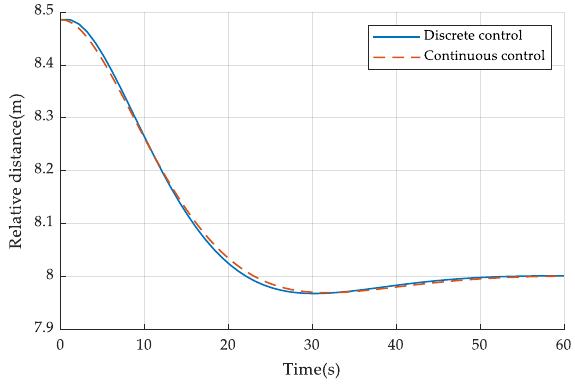
Figure 14. Relative distance curve.